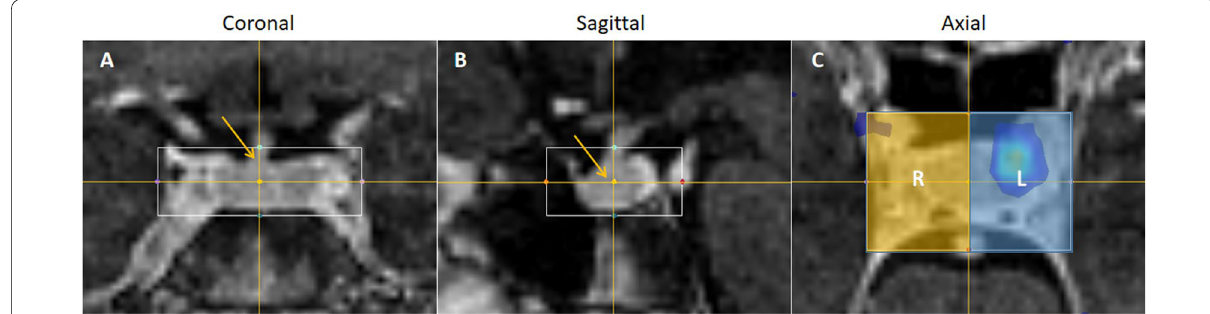
Fig. 4 Lateralization CNR. a Coronal plane of FSPGR MR image used to find the midline of pituitary stalk. b Sagittal plane used to find the center of the pituitary gland. c Illustration of volumes of interest used to find left [blue] and right [yellow] maximum signals